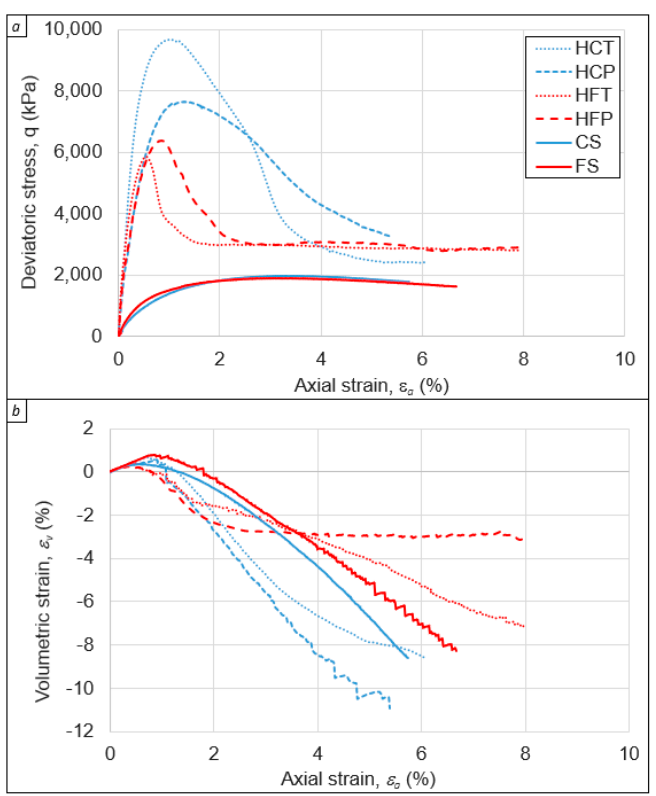
Figure 11. Stress-strain response of sand specimens with and without hydrate with ( a ) Deviatoric stress vs. axial strain, ( b ) Volumetric strain vs. axial strain. Dilation of specimen corresponds to − ve strains and +ve strains correspond to compression of the specimen.